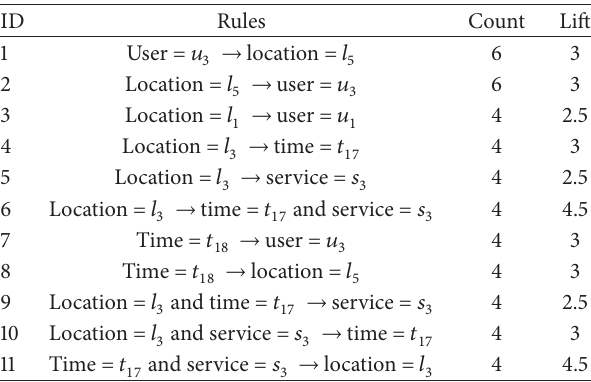
Table 9: The results based on CARMA algorithm.